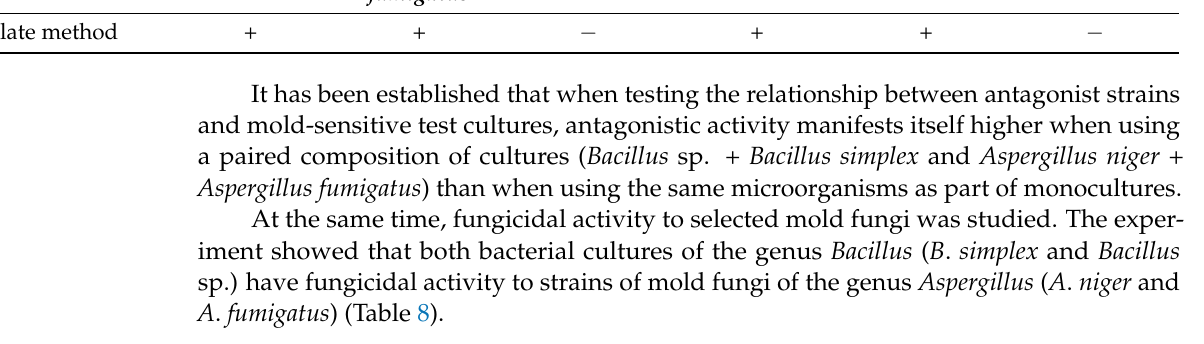
Table 8. Fungicidal activity of the selected strains (+ test is positive; − test is negative; (+) test is weakly